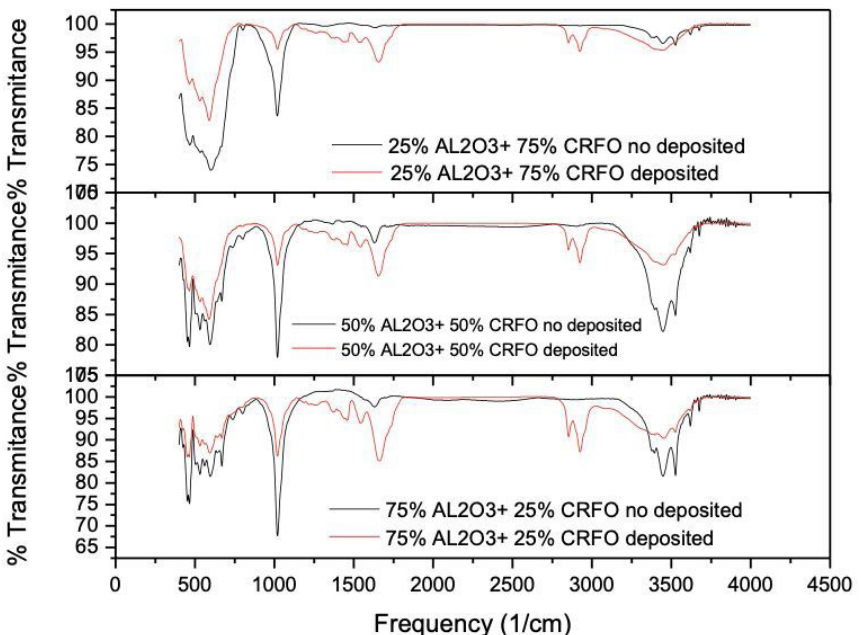
Figure 9. Sample transmittance